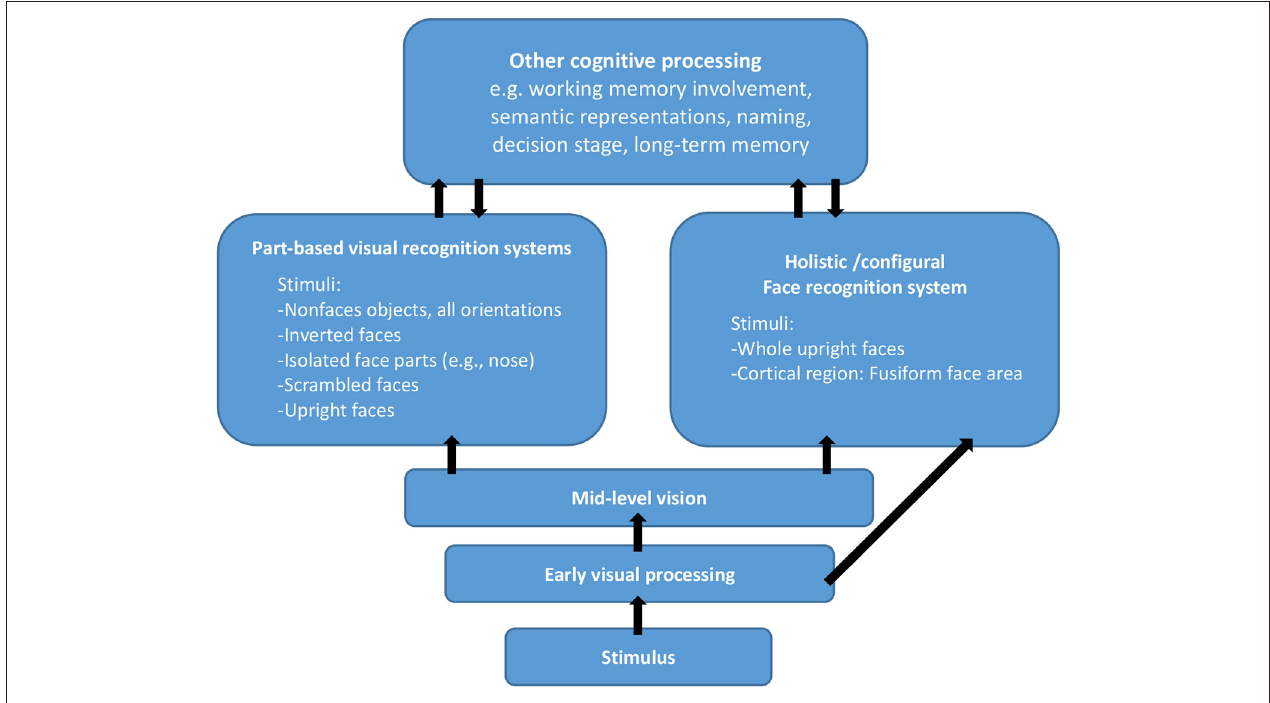
FIGURE 1 | A possible architecture for holistic/configural processing (re-drawn from McKone, 2010).